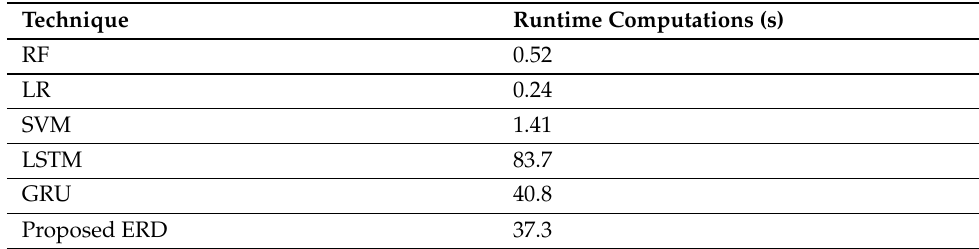
Table 8. The computational complexity analysis of the applied models.